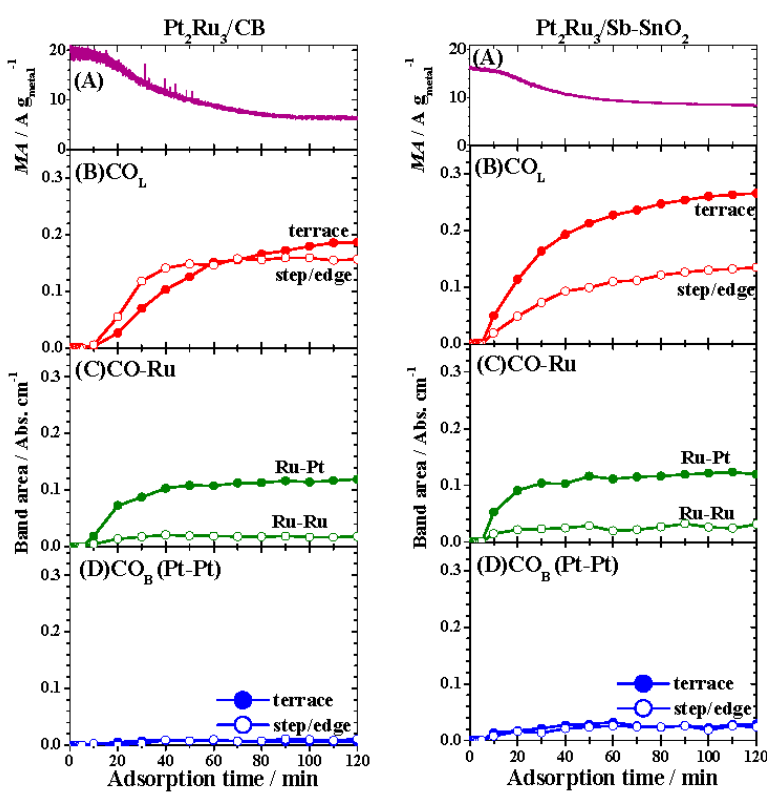
Figure 7. Changes in the mass activity for the HOR ( A ) and integrated intensities of I [CO L ] ( B ); I [CO ‐ Ru] ( C ); and I [CO B ] ( D ) observed at 0.02 V and 60 °C in 1% CO (H 2 ‐ balance) ‐ saturated 0.1 M HClO 4 .